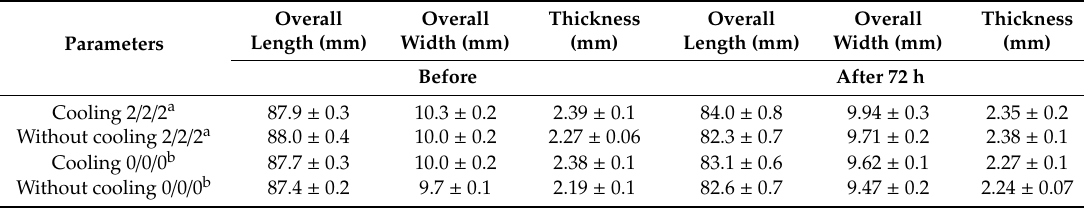
Table 3. The results of the experiment with the cooling fan.